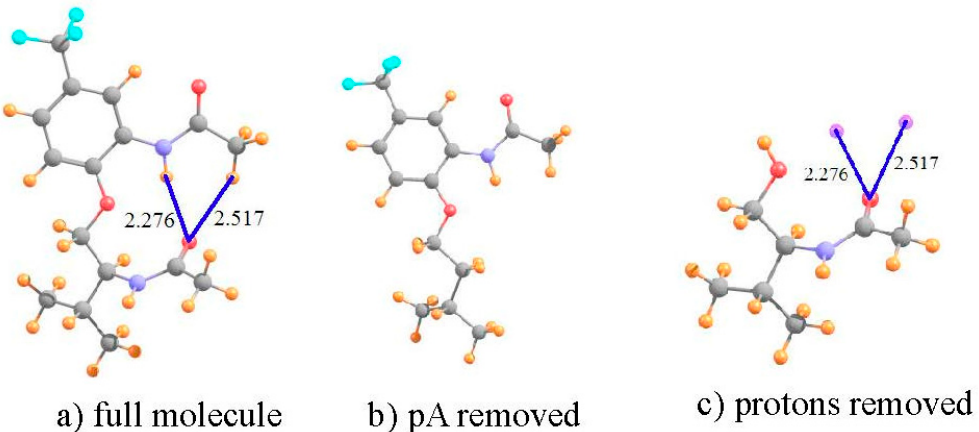
Figure 1. Structures of: ( a ) full molecule I ; ( b ) I with lower amide group removed; and ( c ) I without upper phenyl ring and amide group. Small purple spheres in ( c ) indicate positions of upper amide protons involved in putative HBs. All distances in Å. Table 1. NMR isotropic shielding (ppm) of molecules and indicated derivatives shown in Figures 1 and 2, along with density at bond critical points ( ρ BCP ), in 10 − 3 au (mau).